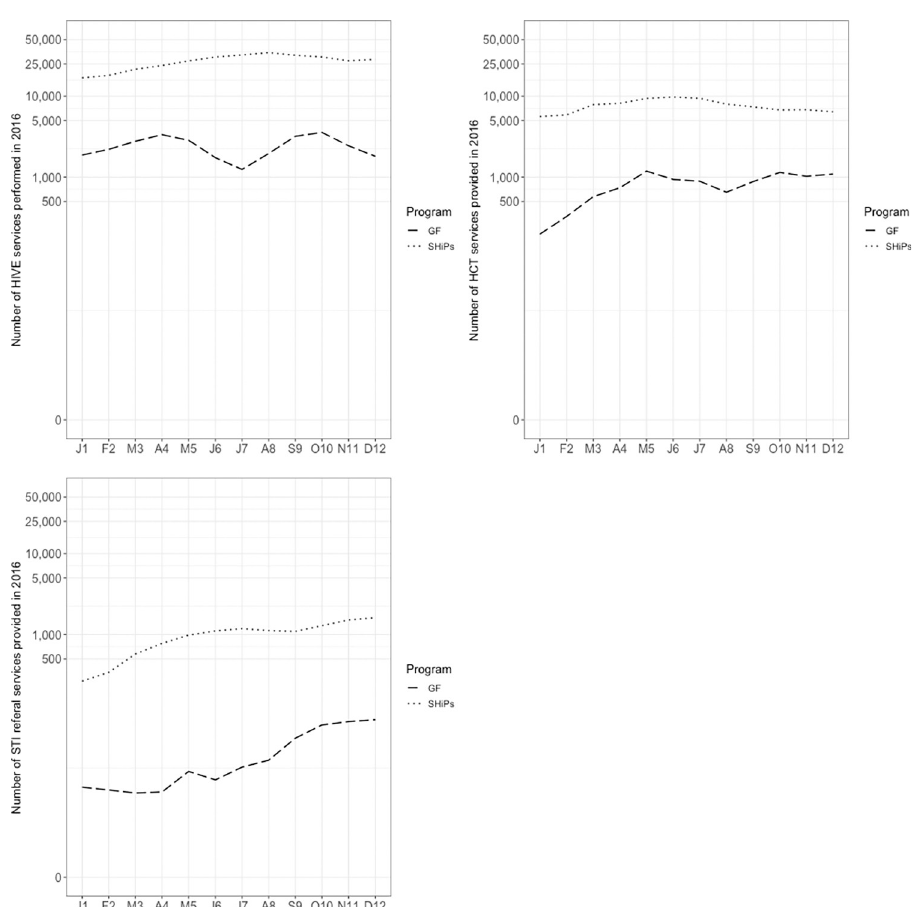
Fig 3. Number of services performed by community-based organizations providing HIV prevention services in Nigeria throughout the 2016 year, by program. Note: the graph shows the rolling 3-month average number of